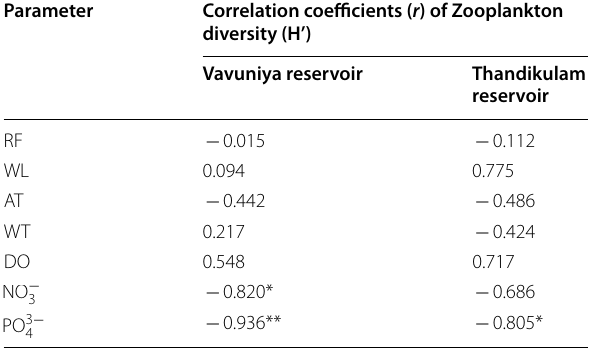
*Correlation is significant at the 0.05 level (1- tailed) **Correlation is significant at the 0.01 level (1- tailed)